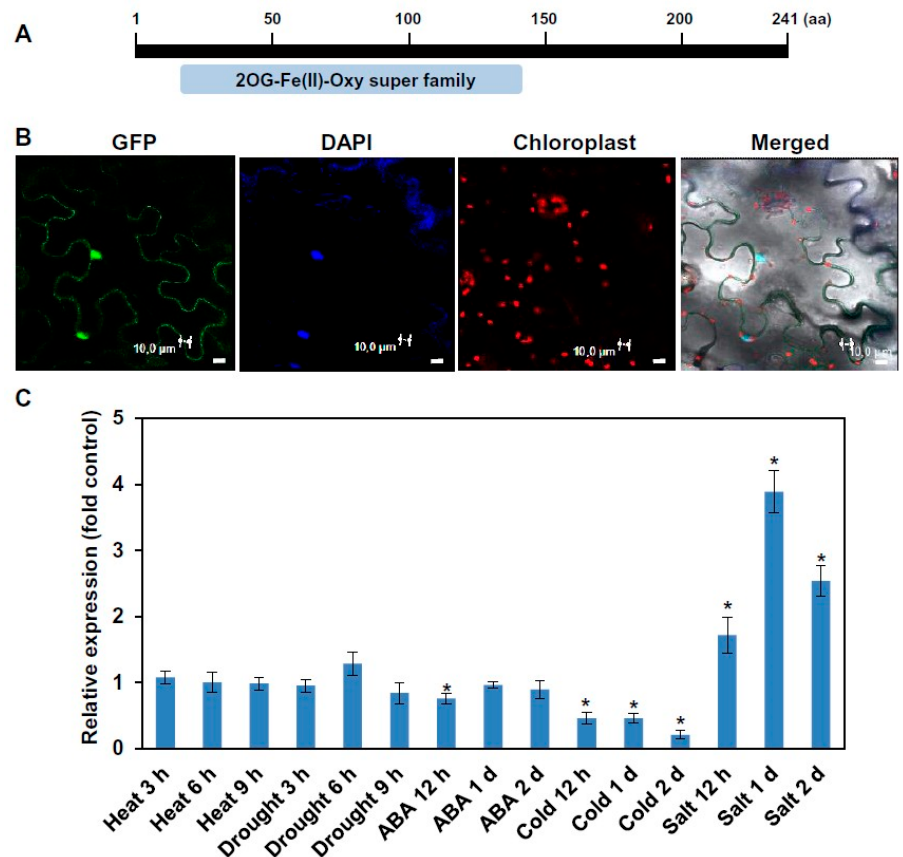
Figure 1. Subcellular localization and stress-responsive expression patterns of ALKBH6. ( A ) Schematic representation of the domain structure of ALKBH6. The conserved 2-oxoglutarate (2OG) and Fe(II)-dependent oxygenase (Oxy) domain is shown. aa, amino acid. ( B ) The ALKBH6-green fluorescence protein (GFP) fusion protein was transiently expressed in tobacco leaves, and the fluorescence signals were detected using a confocal microscope. 4 ′ ,6-diamidino-2-phenylindole (DAPI) was used to stain the nucleus, and the red signals indicate chloroplast auto-fluorescence. Bar = 10 µ m. ( C ) Two-week-old Arabidopsis seedlings were subjected to drought, heat (42 °C), cold (10 °C), high salinity (300 mM NaCl), or abscisic acid (ABA) (100 μ M) treatment, and the transcript levels of ALKBH6 were determined via real-time RT-PCR. Values are the mean ± SE obtained from three independent experiments, and the asterisks above columns indicate significant differences (* p ≤ 0.05).